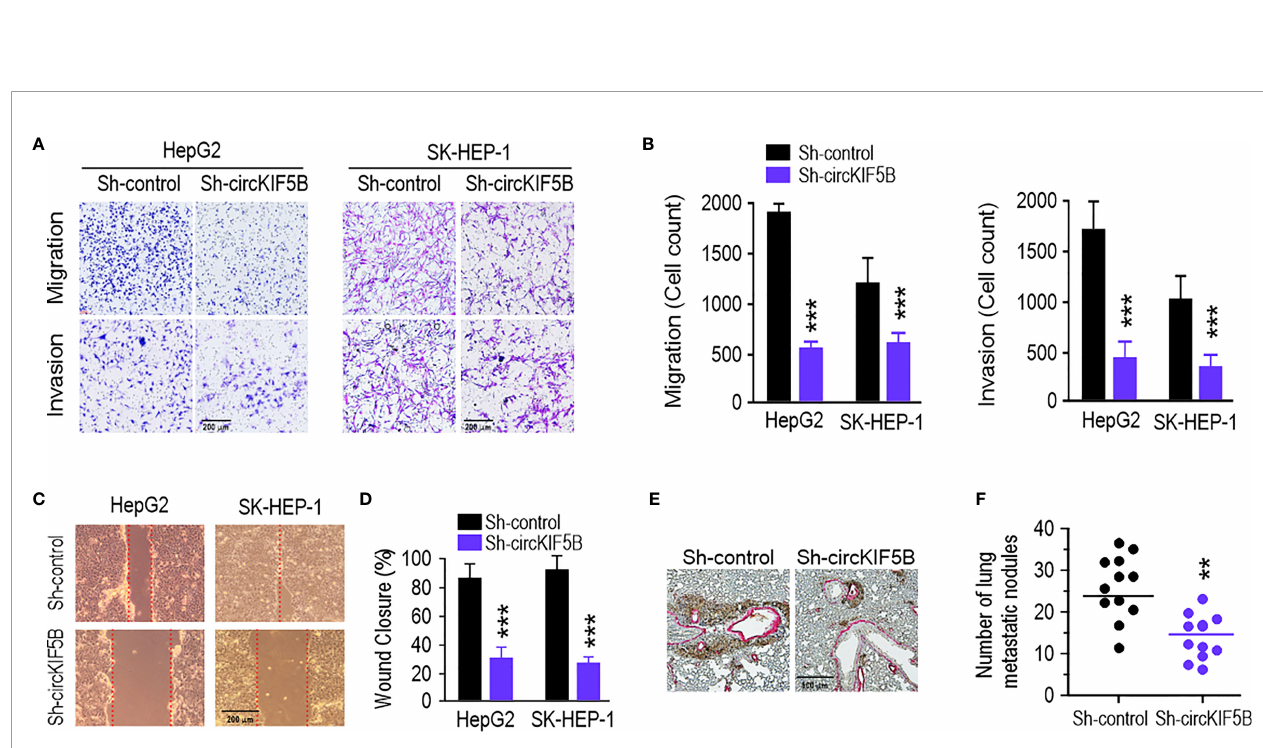
FIGURE 2 | CircKIF5B knockdown inhibits growth and metastasis of HCC cells. (A) Knockdown ef fi ciency of si-circKIF5B in HepG2 and SK-HEP-1 cells. (B) Cell viability by CCK-8 assay in HepG2 and SK-HEP-1 cells. (C) Colony-forming ability in HepG2 and SK-HEP-1 cells. (D) Quanti fi cation of panel ( C ). (E) Xenograft assay with HepG2 stable cell lines. (F) Knockdown of circKIF5B decreased the volume of the HepG2 xenograft tumors. (G) Knockdown of circKIF5B decreased the weight of the HepG2 xenograft tumors. *p < 0.05, **p < 0.01, ***P < 0.005.